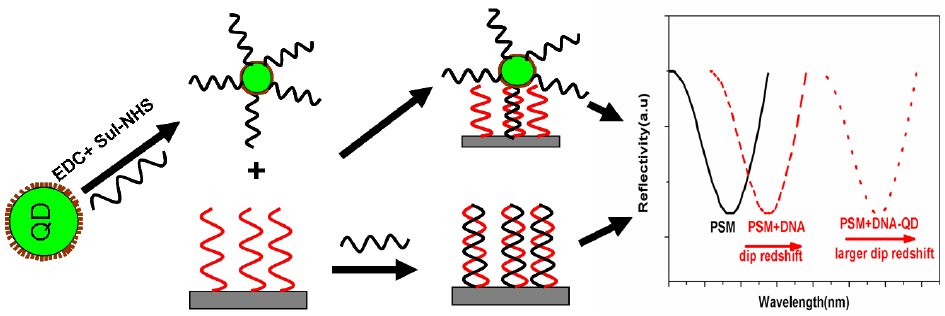
Figure 1. Schematic diagram of the sensing principle.